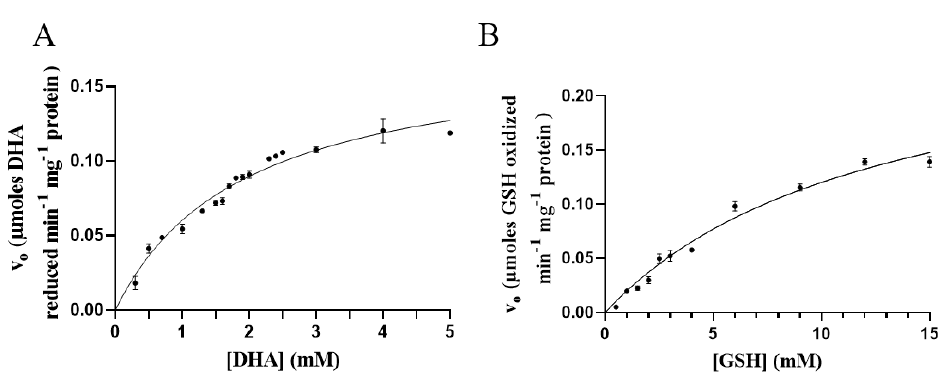
Figure 5. Michaelis – Menten plot of the rate of conversion of DHA ( A ) and GSH ( B ) by the novel DHAR.